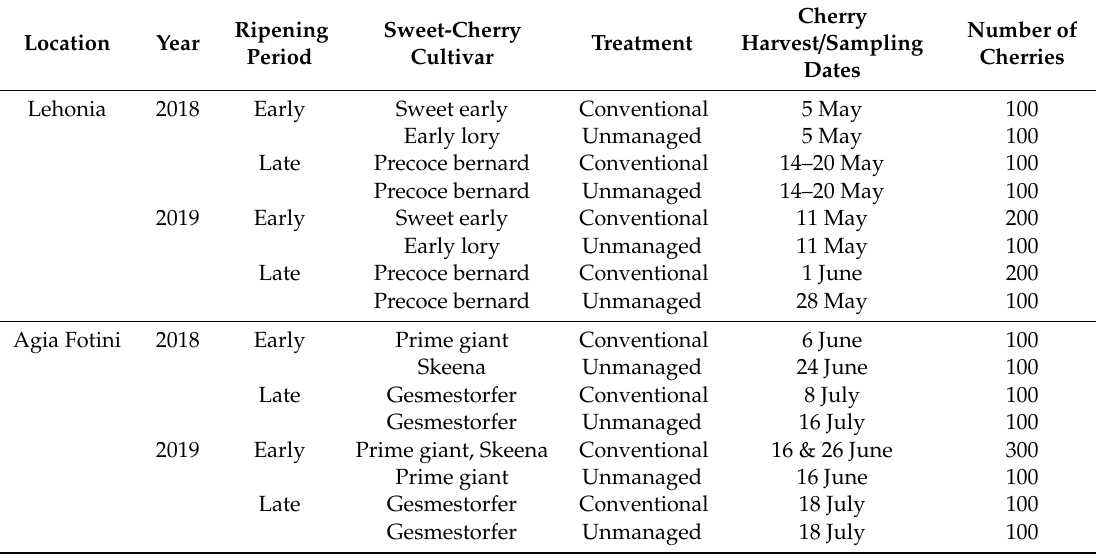
Table 2. Sampling dates and amount of cherries collected from early and late maturing cherry cultivars of conventionally managed and abandoned / unmanaged trees in Lehonia and Agia Fotini during 2018 and